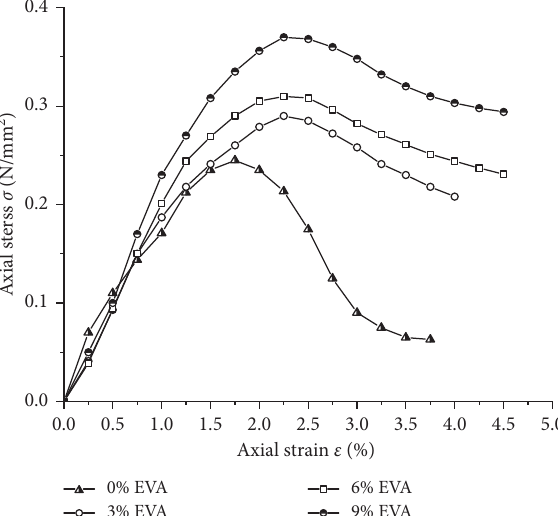
Figure 3: Unconfined compressive strength of the soil blended with cement and EVA at various fractions.